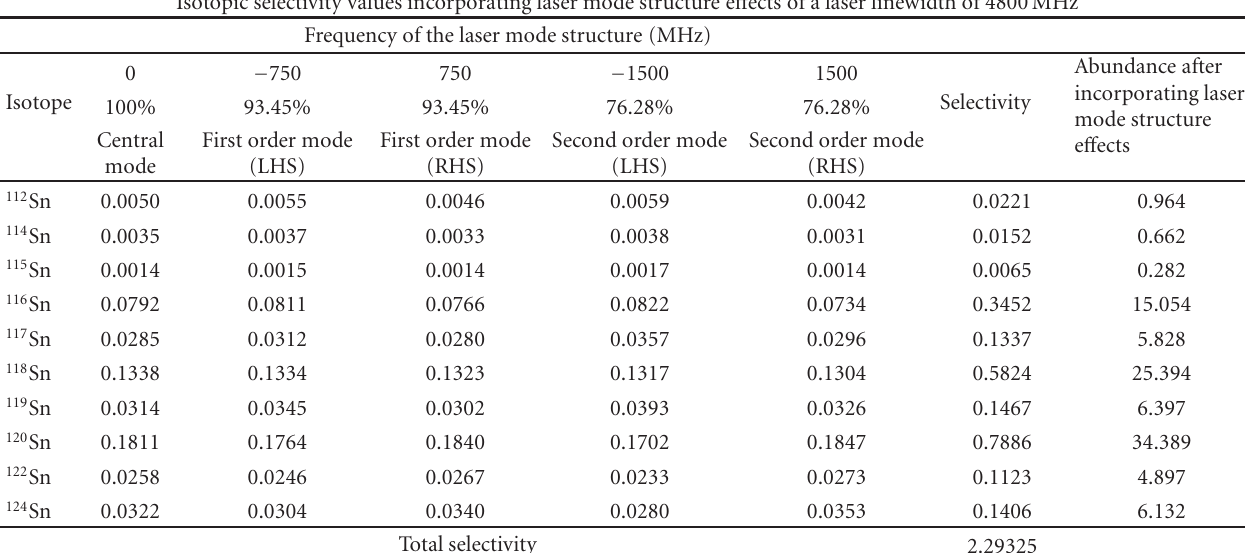
Table 6: A table of theoretically computed isotopic selectivity and abundance values after incorporating laser mode structure e ff ects of a laser with a linewidth of